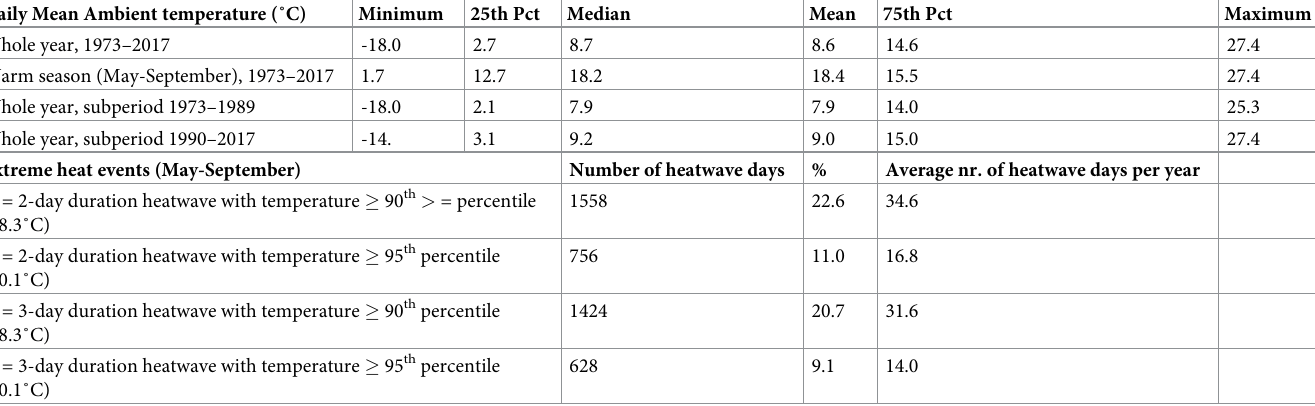
Table 2. Descriptive statistics for daily mean ambient temperature (for the entire study period, the warm season (May-September) and each subperiod) and heat- waves (two or three days of duration and temperature equal or above the 90 th or 95 th percentile. Daily Mean Ambient temperature (˚C)